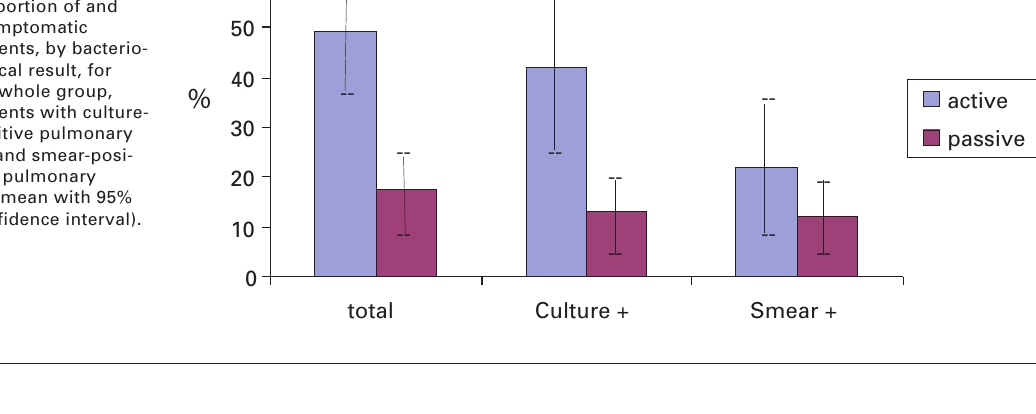
Figure 4 Outcome of treat- ment of TB, by screening procedure (all cases, including retreatment but ex- cluding 12 cases with missing final infor- mation). “Cured”: pa- tient with bacterio- logical proof of nega- tivation. “Com- pleted”: patients